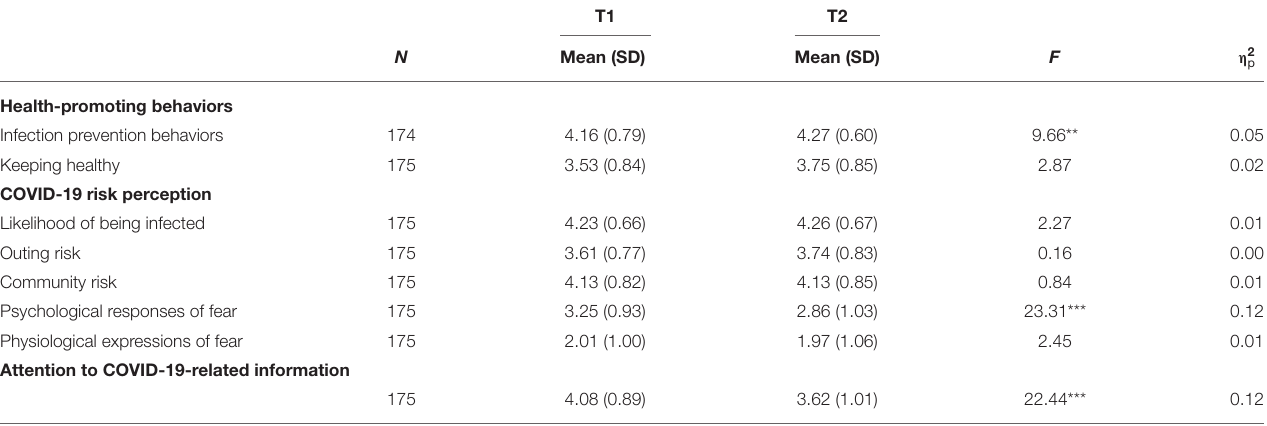
TABLE 2 | Results of repeated measure ANOVAs of the differences in health-promoting behaviors, COVID-19 risk perceptions, and attention to COVID-19-related information.